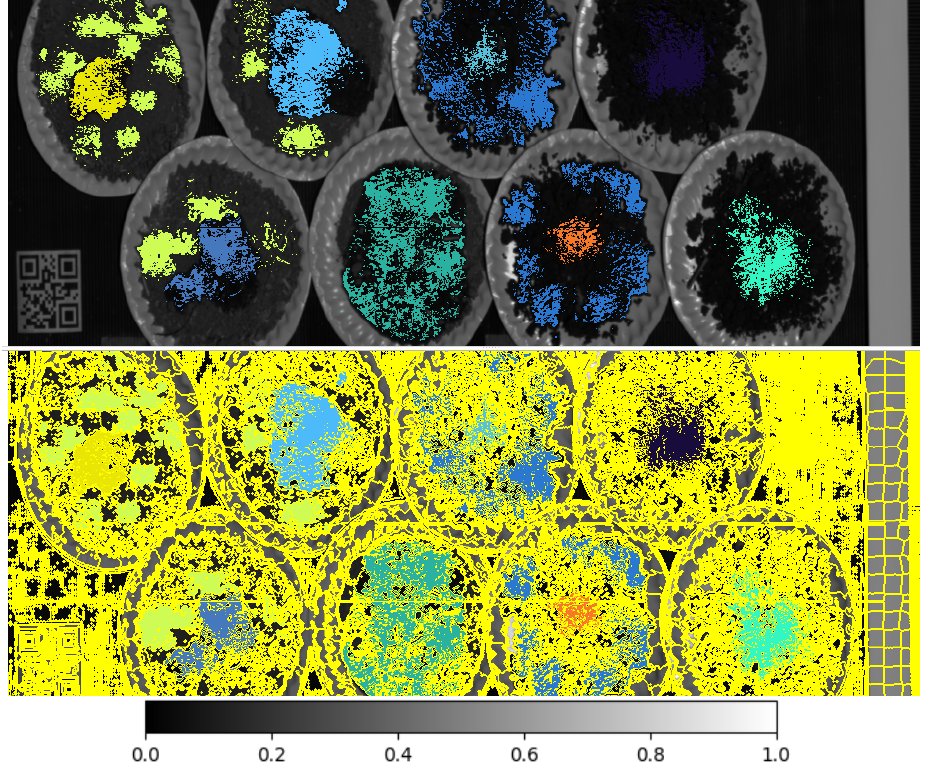
Figure 8. HySSIC applied to oil-doped soil samples. Top: clusters for doped areas. Down: full HySSIC clustering output. Colormap: black and gray colors describe background and objects in the image; yellow lines describe the boundaries of the clusters. The remaining colors define pixels sharing the same